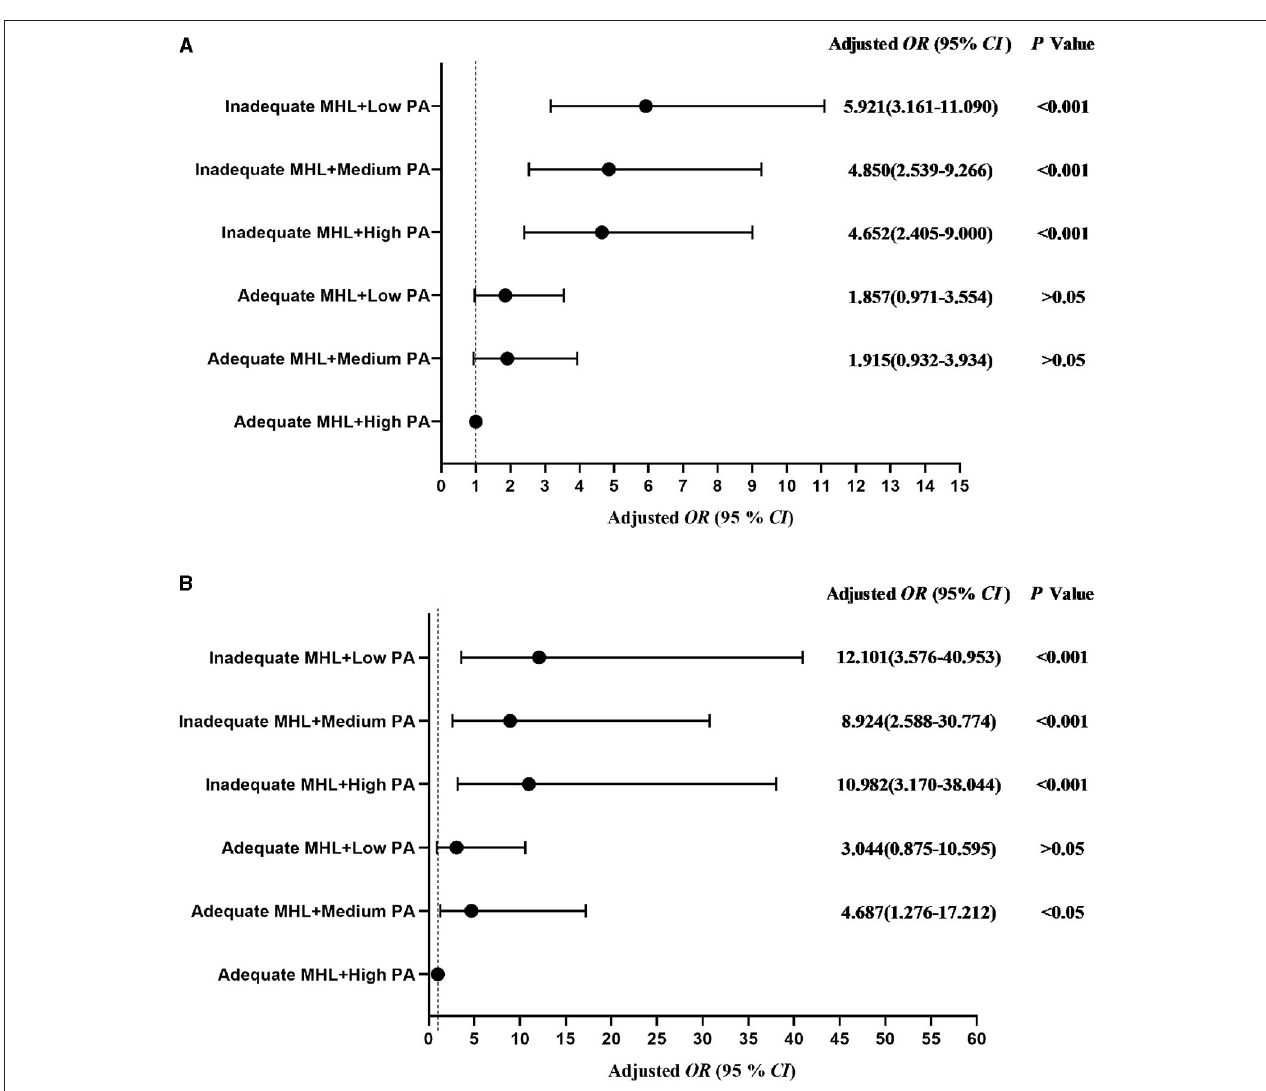
FIGURE 2 | Odds ratio (95% CI ) associated with the interactions of physical activity rank, mental health literacy, depressive symptoms and anxiety symptoms in college students. (A) Depressive symptoms, (B) Anxiety symptoms. MHL, mental health literacy; PA, physical activity; OR , odds ratio; CI , confidence interval. Adjusted for gender, grade, registered residence, parents’ educational level, self-reported family economy, cigarette use, alcohol